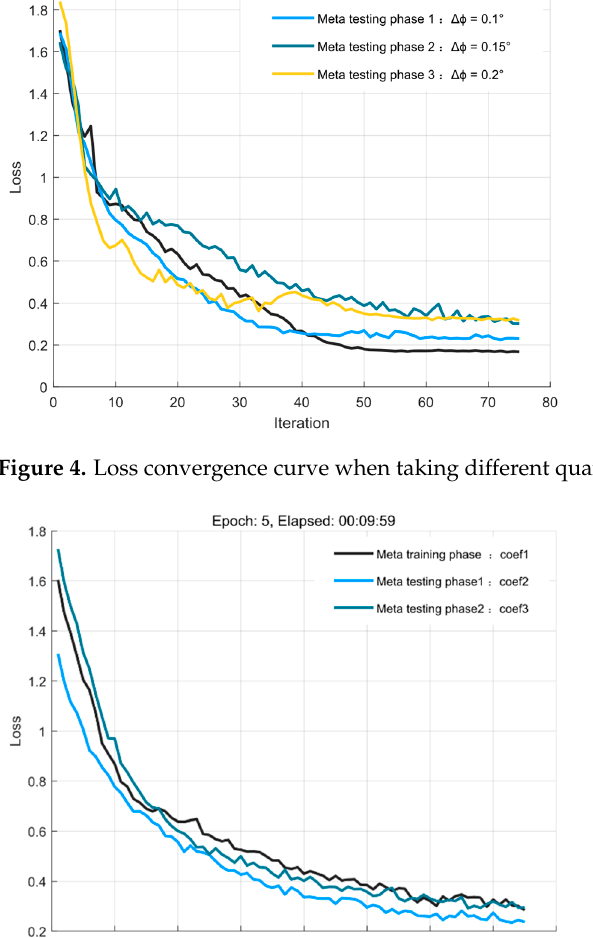
Figure 4. Loss convergence curve when taking different quantization.